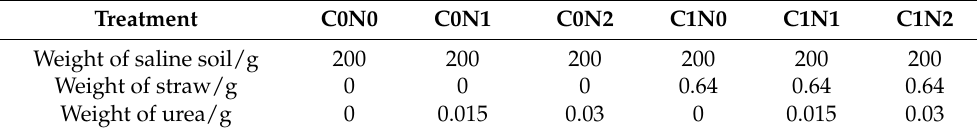
Table 2. Design of the nitrogen transformation experiment on returning straw and applying